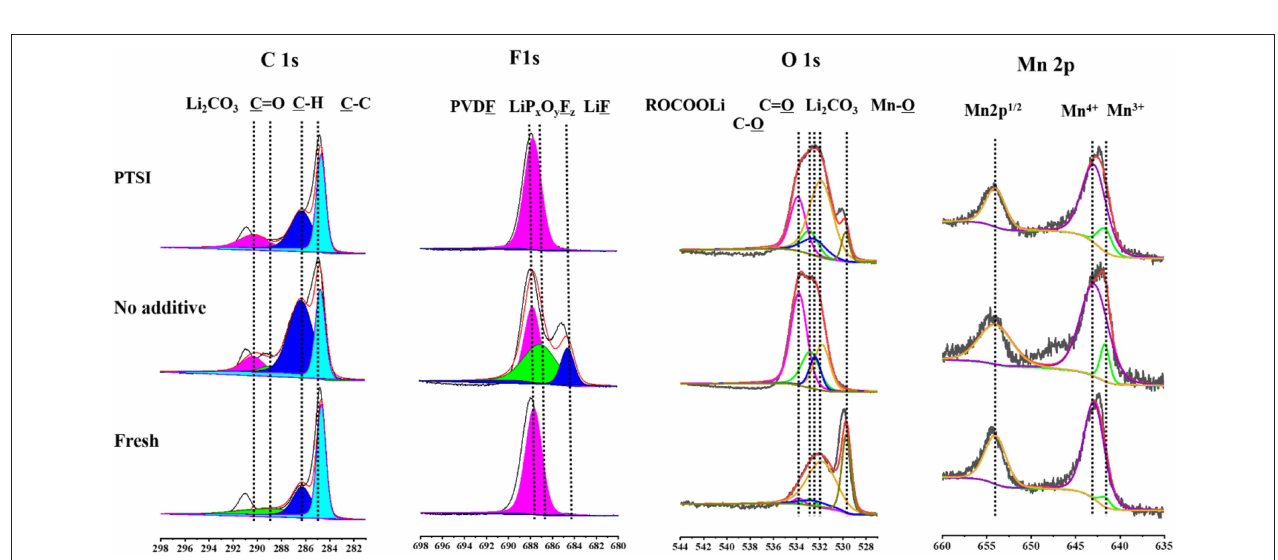
FIGURE 6 | XPS survey spectra of LNMO electrode with 0.5 wt.% PTSI and with no additive after 40 cycles.